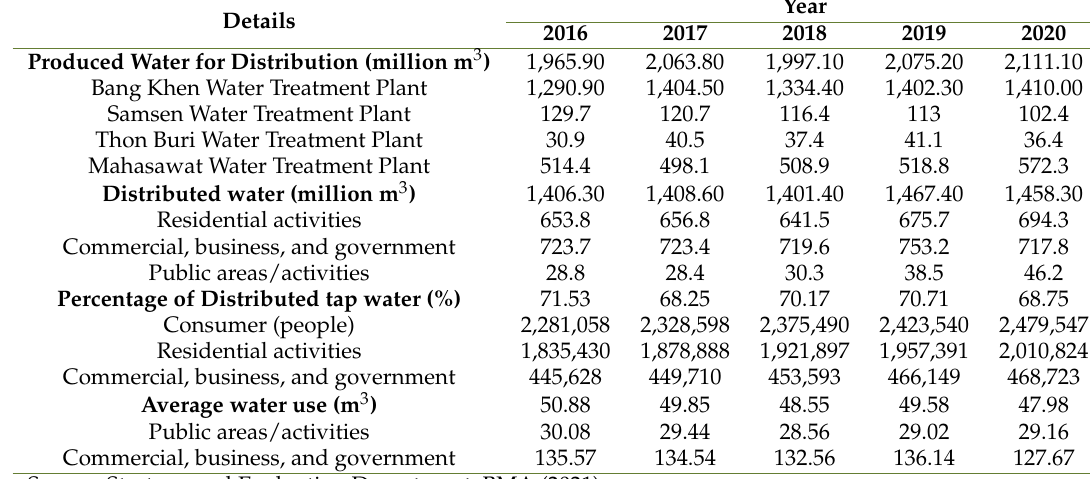
Table 1. Water production and distribution and consumers in the served areas (2016-2020)